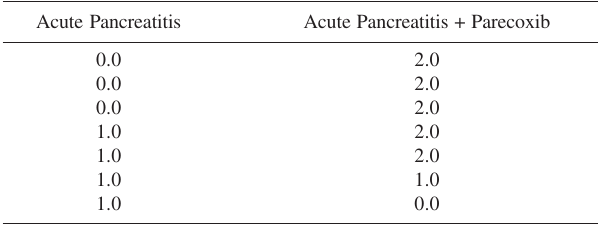
Table 1 . Effect of Cox-2 inhibition on fat necrosis, according to Schmidt’s scale, 30 showing higher fat necrosis in parecoxib-treated rats ( P = 0. 0.0289).